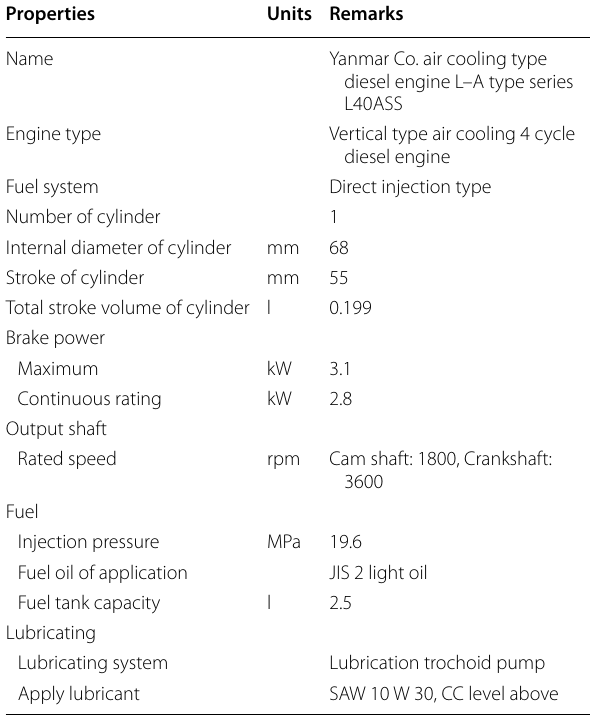
Table 1 Specifications of the diesel engine